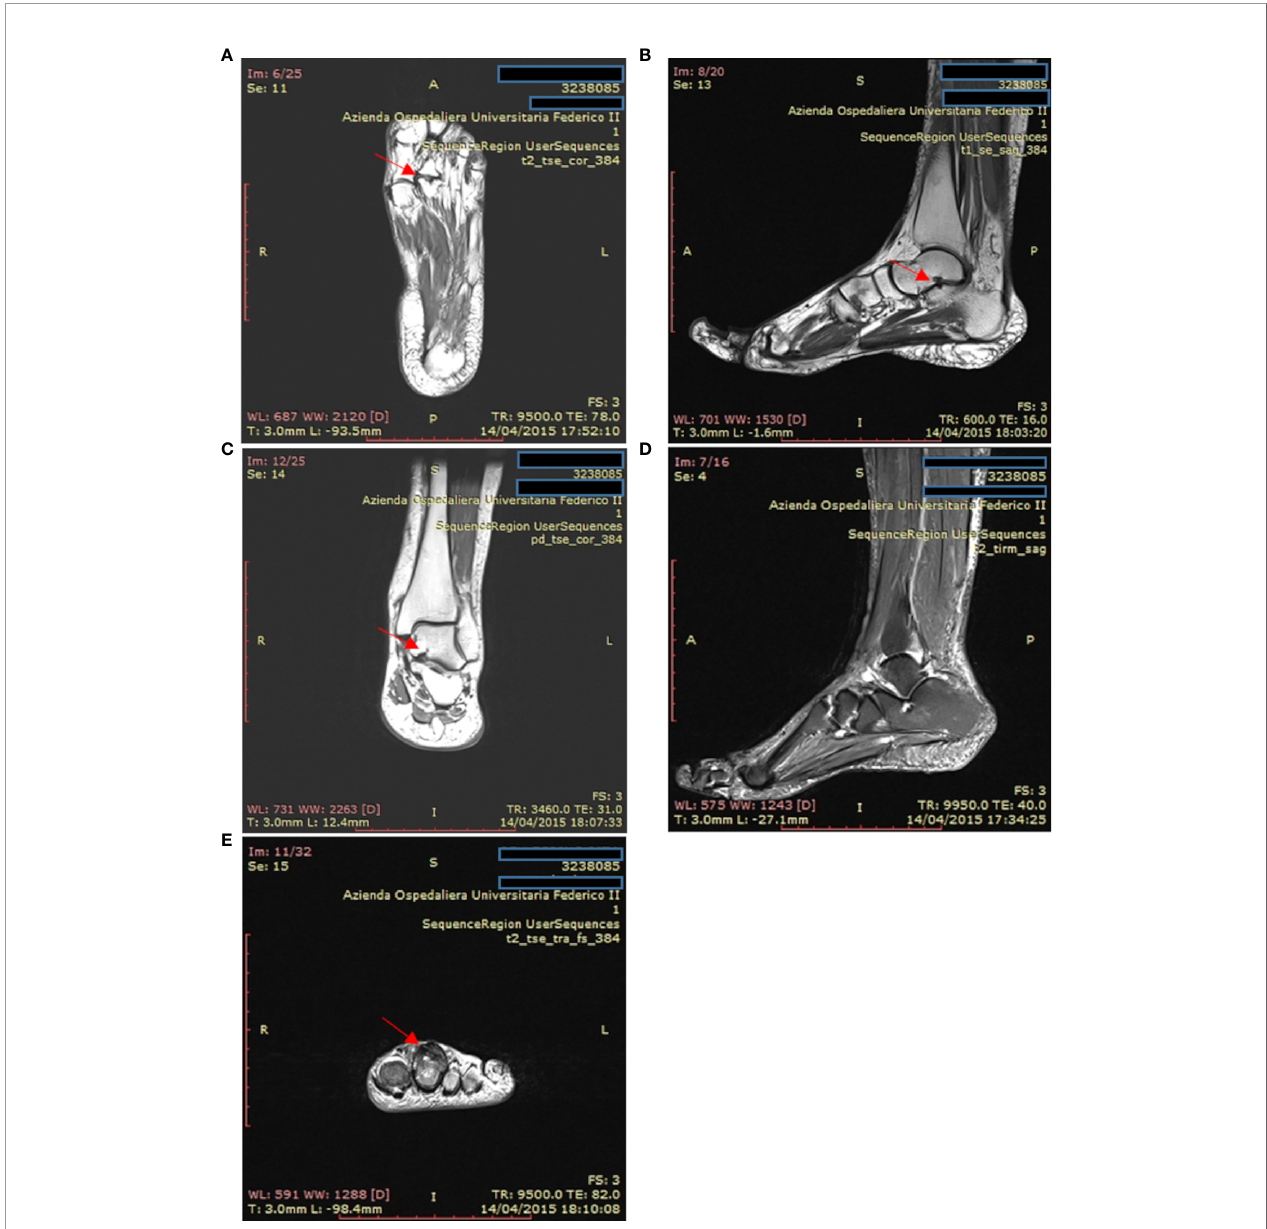
FIGURE 6 | Magnetic resonance imaging of the ankle and foot in a patient with psoriatic arthritis and common variable immunode fi ciency. (A) T2-weighted coronal magnetic resonance images of the left foot in a patient with psoriatic arthritis. Erosions are present at the second metatarsal-phalangeal joint (arrow). (B, C) T1- weighted sagittal axis and coronal magnetic resonance images showing cystic erosion (7 mm) of the fl oor of the sinus tarsi (arrow). (D) T2-weighted sagittal magnetic resonance images of foot and ankle showing joint effusion in the tibiotarsic compartment and enthesitis at the Achilles tendon insertion. (E) T2-weighted axial magnetic resonance images of the fi ngers from a patient with psoriatic arthritis exhibiting fl exor and extensor tenosynovitis at the second fi nger